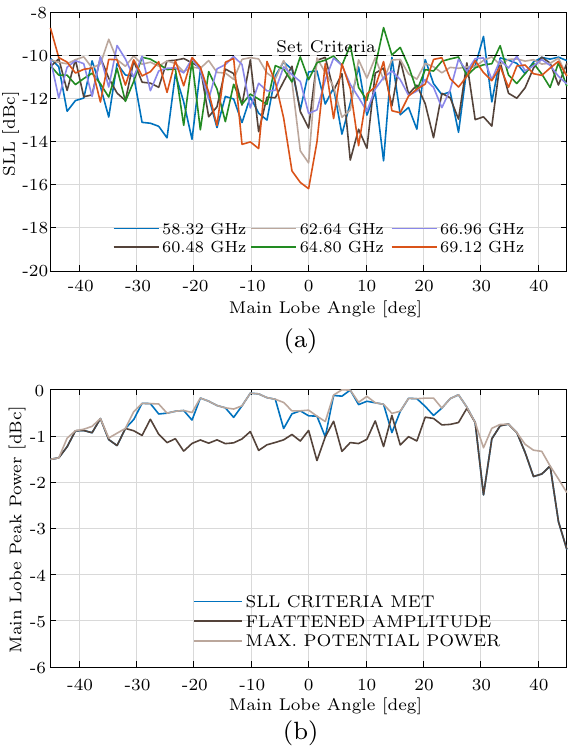
Fig. 6 An example of algorithm performance as measured on a different antenna module type [11] a worst case side lobe levels from combined measurements on 5 units, b comparison of the amplitude envelope at 58.32 GHz between two beam-books and the potential power of the antenna module, when the phase shifters are set to maximum gain